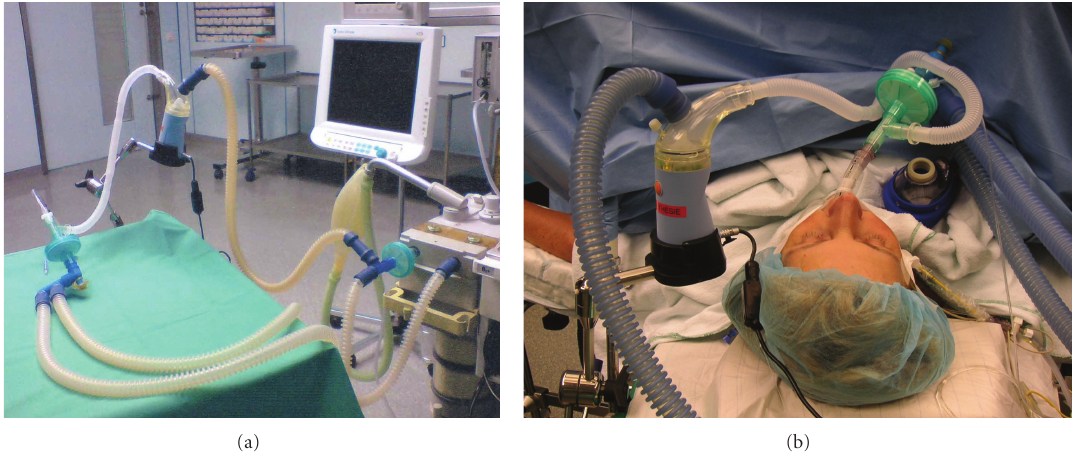
Figure 4: Assembly instruction for the integration of an ultrasonic nebulizer (Multisonic) in the ventilatory circuit. Intraoperative selective pulmonary vasodilation with inhaled iloprost.